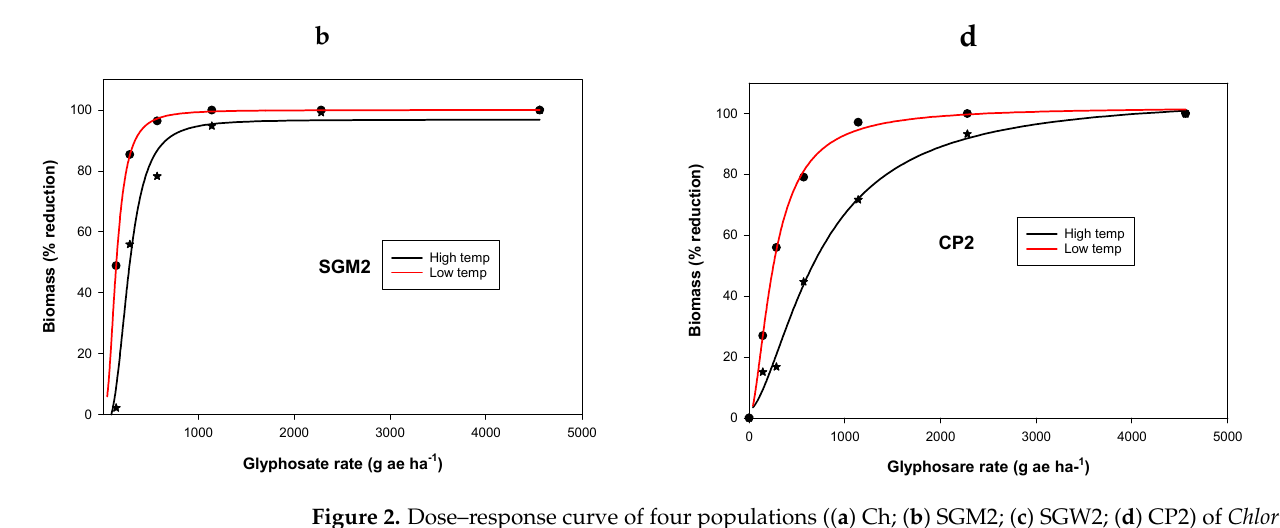
Figure 2. Dose–response curve of four populations (( a ) Ch; ( b ) SGM2; ( c ) SGW2; ( d ) CP2) of Chloris virgata for percentage biomass reduction. The curve is a log-logistic regression model fitted to data. Parameter estimates are provided in Table 3. Table 3. Estimates of regression parameters and doses required for 50% biomass reduction (GR 50 ) of Chloris virgata populations in dose–response studies conducted at high (35/25 °C) and low-tem- perature (25/15 °C) regimes in the glass house.